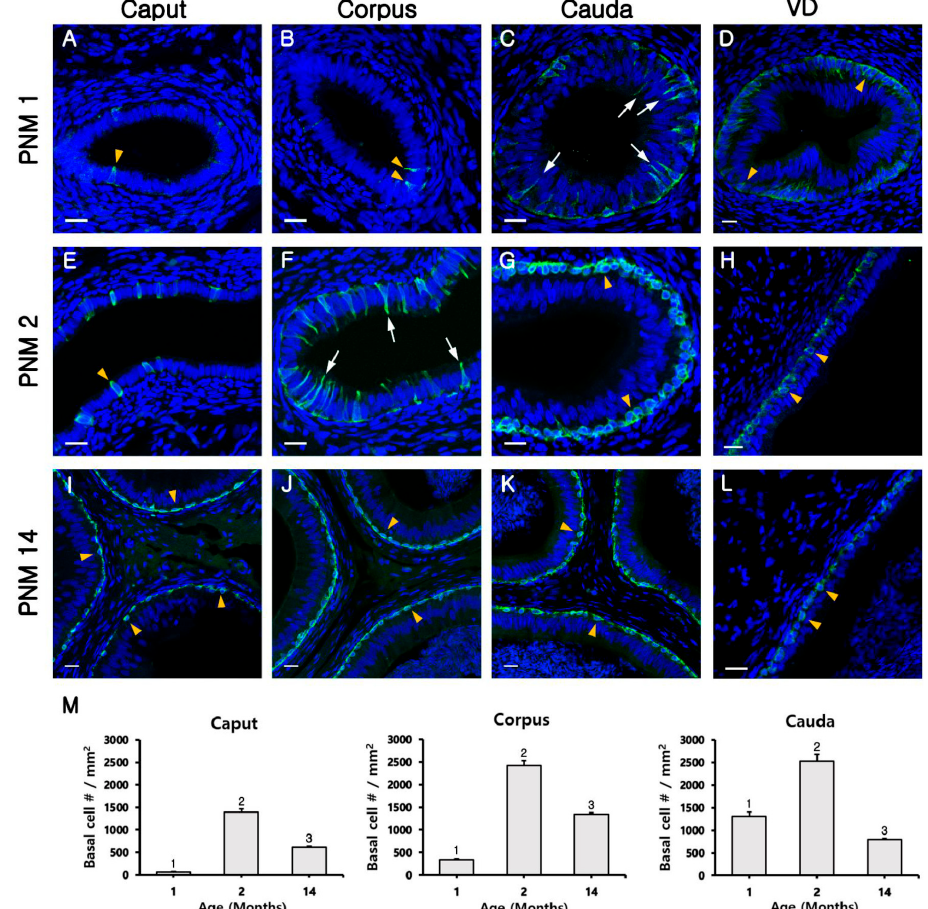
Figure 3. Progressive appearance of basal cells (BCs) from the vas deferens (VD) to the caput of the goat epididymis. Basal cells in the epididymis were labeled for KRT5 (green). ( A–D ) The epididymis at postnatal month (PNM) 1. ( E–H ) The epididymis at PNM2. ( I–L ) The epididymis at PNM14. The arrows and arrowheads indicate projecting and non-projecting BCs, respectively. The nuclei were labeled with DAPI (blue); S, spermatozoa. Bars = 20 µm. ( M ) Change in the volume of BCs in the caput, corpus, and cauda. Cell numbers were calculated based on the number of BCs in the epithelium per square millimeter of the epididymis area. The results are expressed as the mean ± standard error of the mean. Different letters indicate significant differences ( p < 0.05).